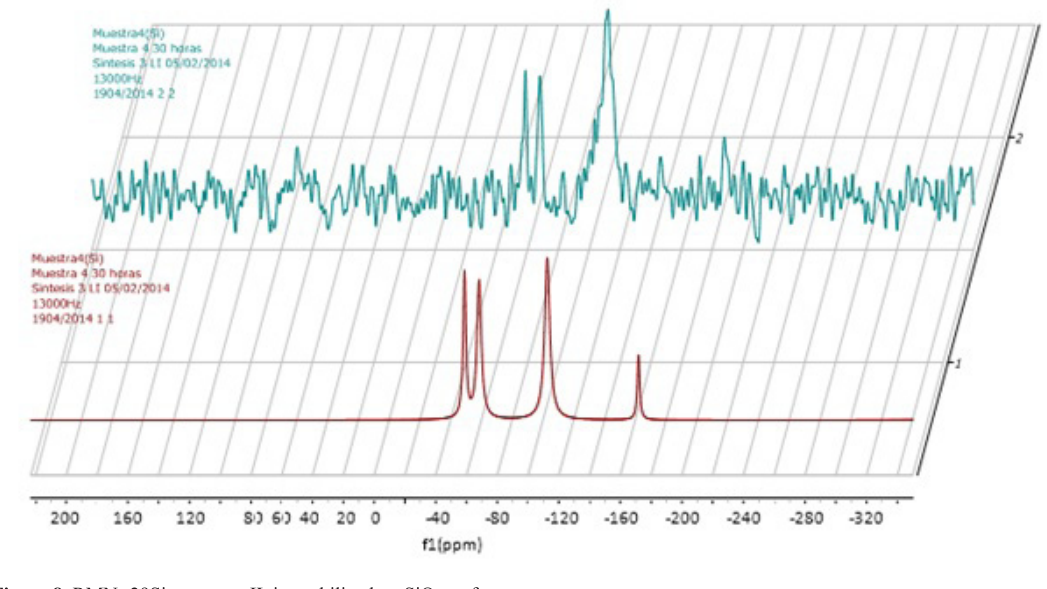
Figure 8. RMN- 29Si spectrum IL immobilized on SiO